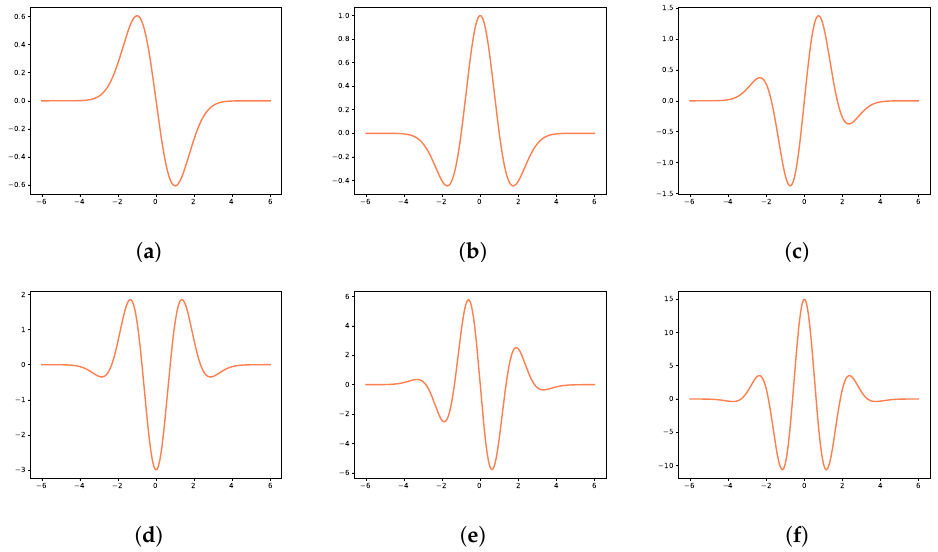
Figure 2. Vanishing momentum wavelets. ( a ) 1-th wavelet ( b ) 2-th wavelet ( c ) 3-th wavelet ( d ) 4-th wavelet ( e ) 5-th wavelet ( f ) 6-th